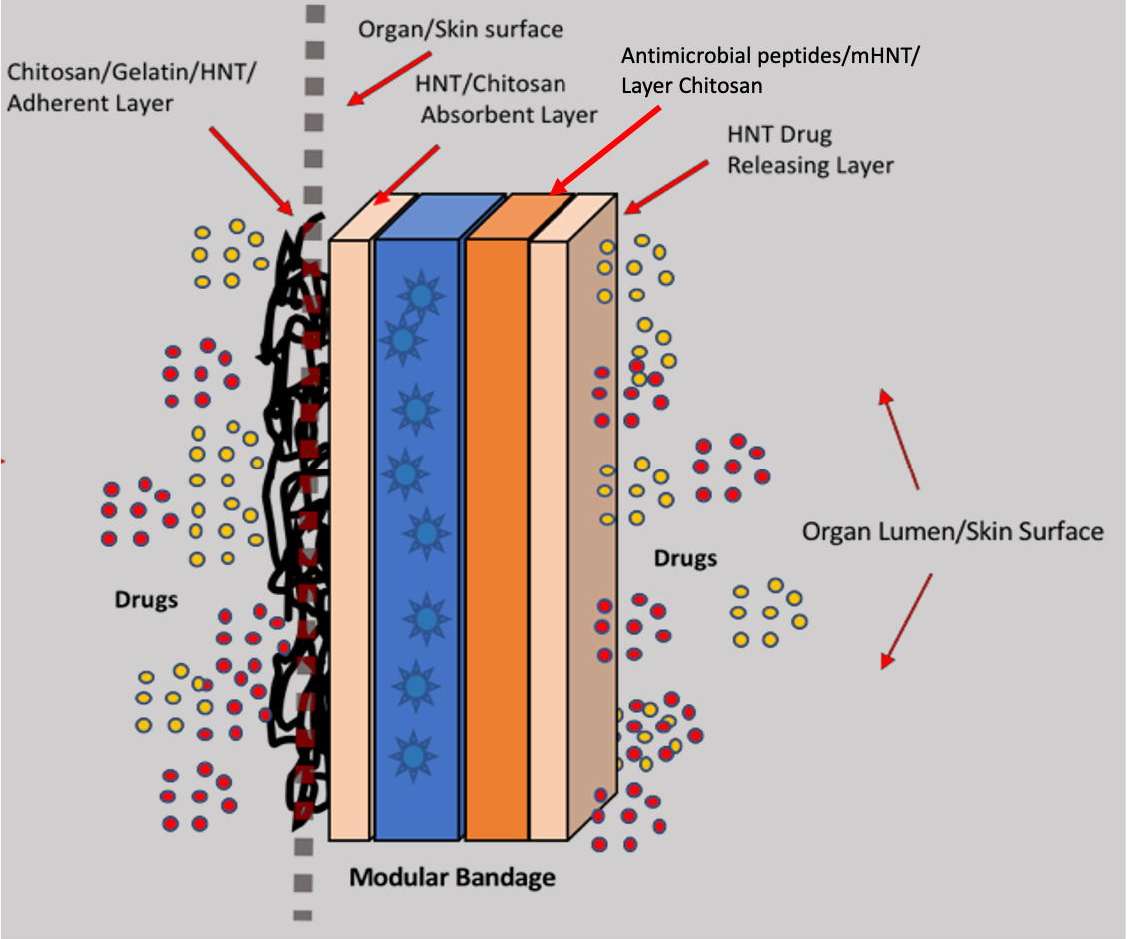
Figure 5. Conceptual idea for a multifunctional bandage. From the communicating author’s collec- tion.